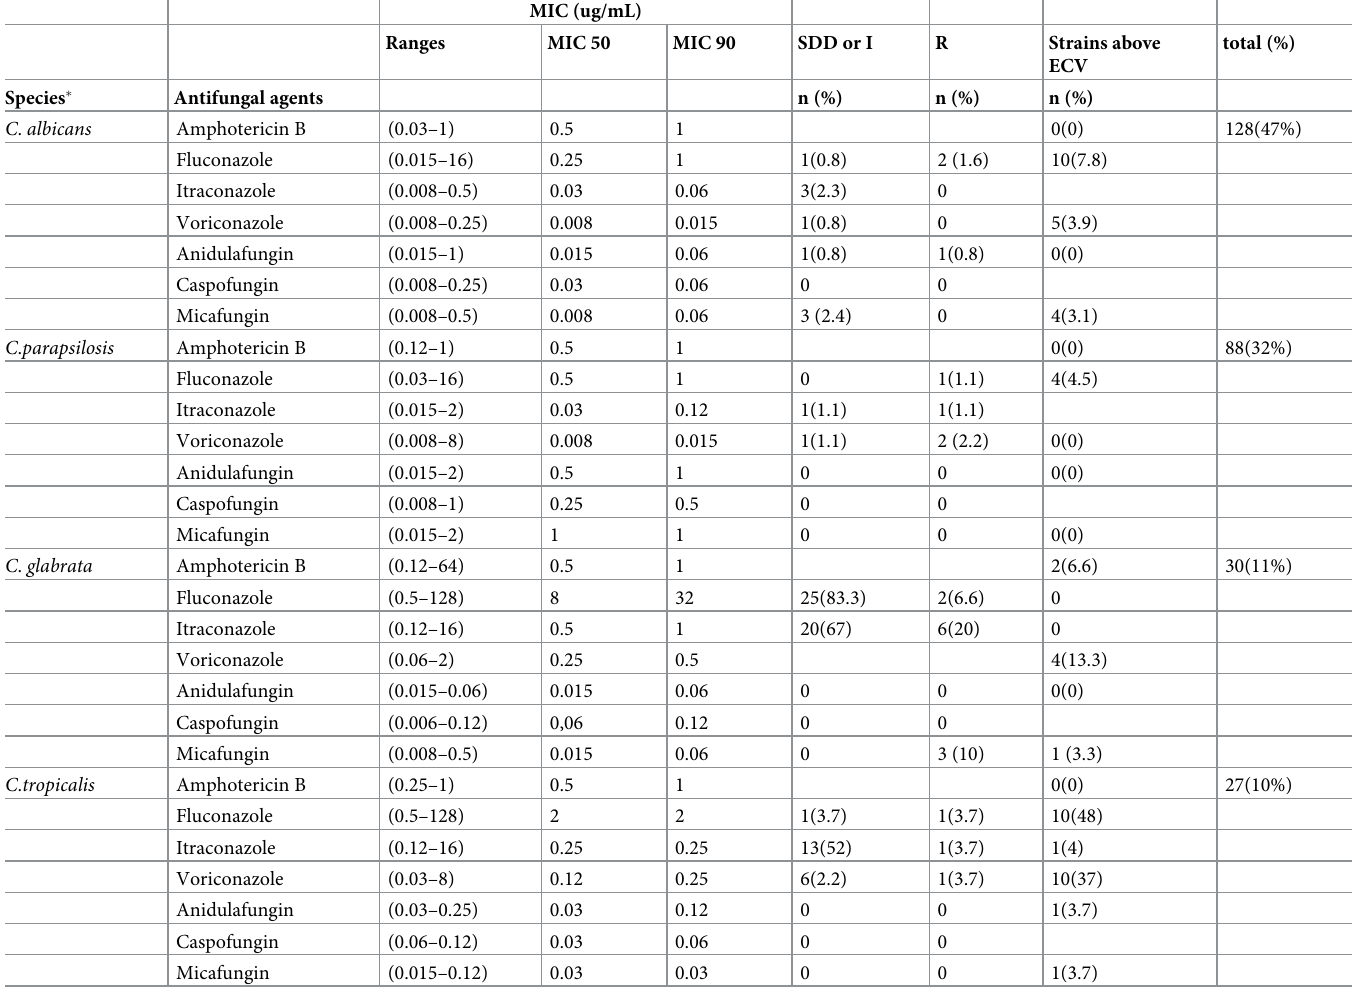
Table 3. In vitro susceptibility of Candida species to seven antifungal